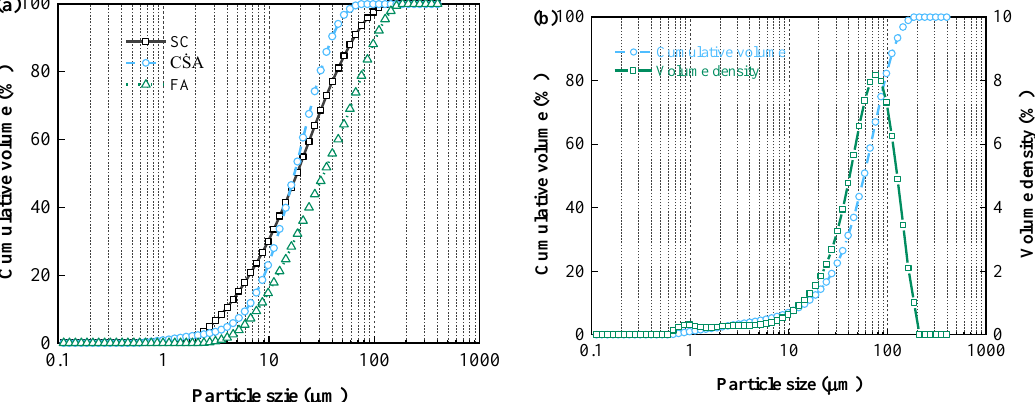
Figure 1. Particle size distribution of ( a ) Slag cement (SC), C˙SA, and fly ash (FA); ( b ) silica tailings (ST). Table 1. Chemical composition of FA, C˙SA, SC, and ST (%).